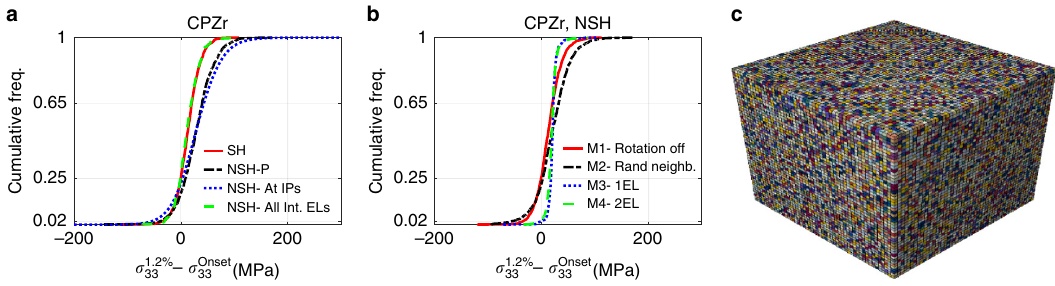
Fig. 8 Modelling results for cumulative frequencies of stress drops. a , b Cumulative frequency of stress drop for different cases examined by CPFE modelling. SH represents strain-hold model and NSH represents the model with no strain hold. In the NSH-P model, parameters reported in Abdolvand et al. 25 were used. c An example of self-consistent type model with fragmented grains, where random positions were assigned to fragments. Each colour represents an